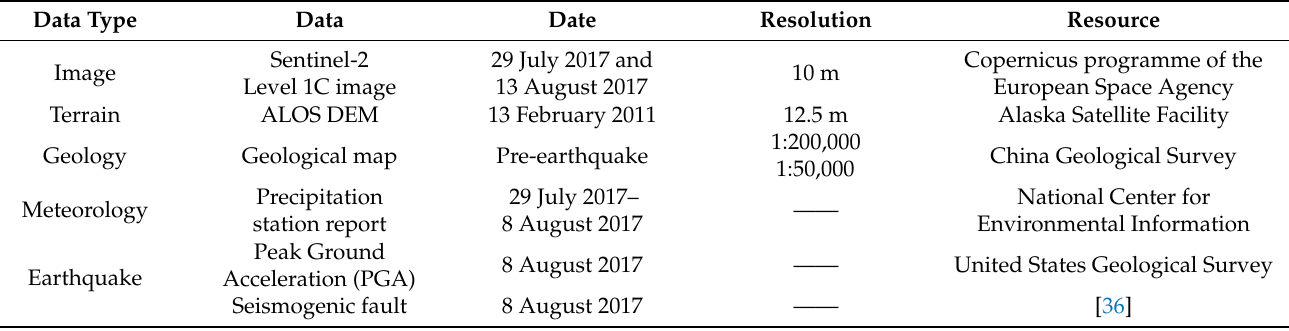
Table 1. Multi-source data for coseismic landslide recognition. ALOS DEM indicates the digital el- evation model produced from Advanced Land-Observing Satellite-1 images.